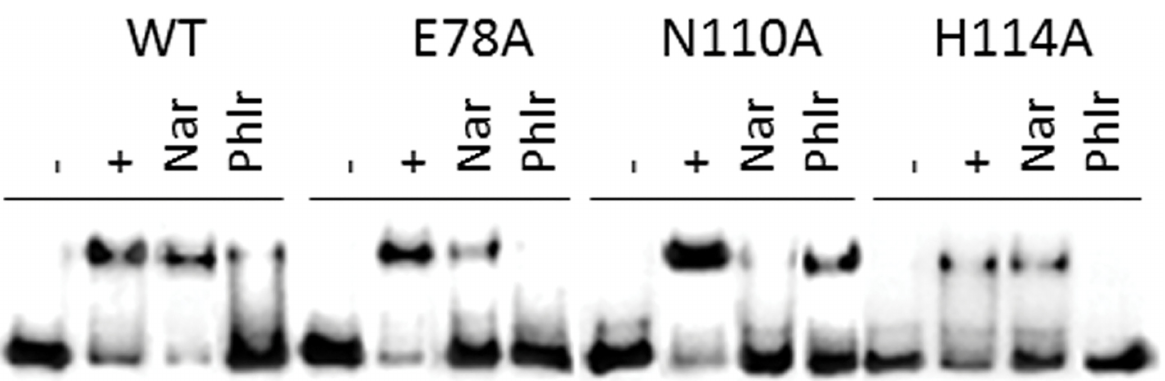
Fig 5. Effect of naringenin and phloretin on the dissociation of TtgR WT and variants (TtgR H114A , TtgR N110A and TtgR E78A ) from ttgR-ttgABC intergenic region by EMSA. (-) 1nM of free labeled operator DNA, (+) DNA-complex with 2 μ M of TtgR WT and its variants, and DNA complex in the presence of 5 μ M of naringenin (Nar) and phloretin (Phlr).